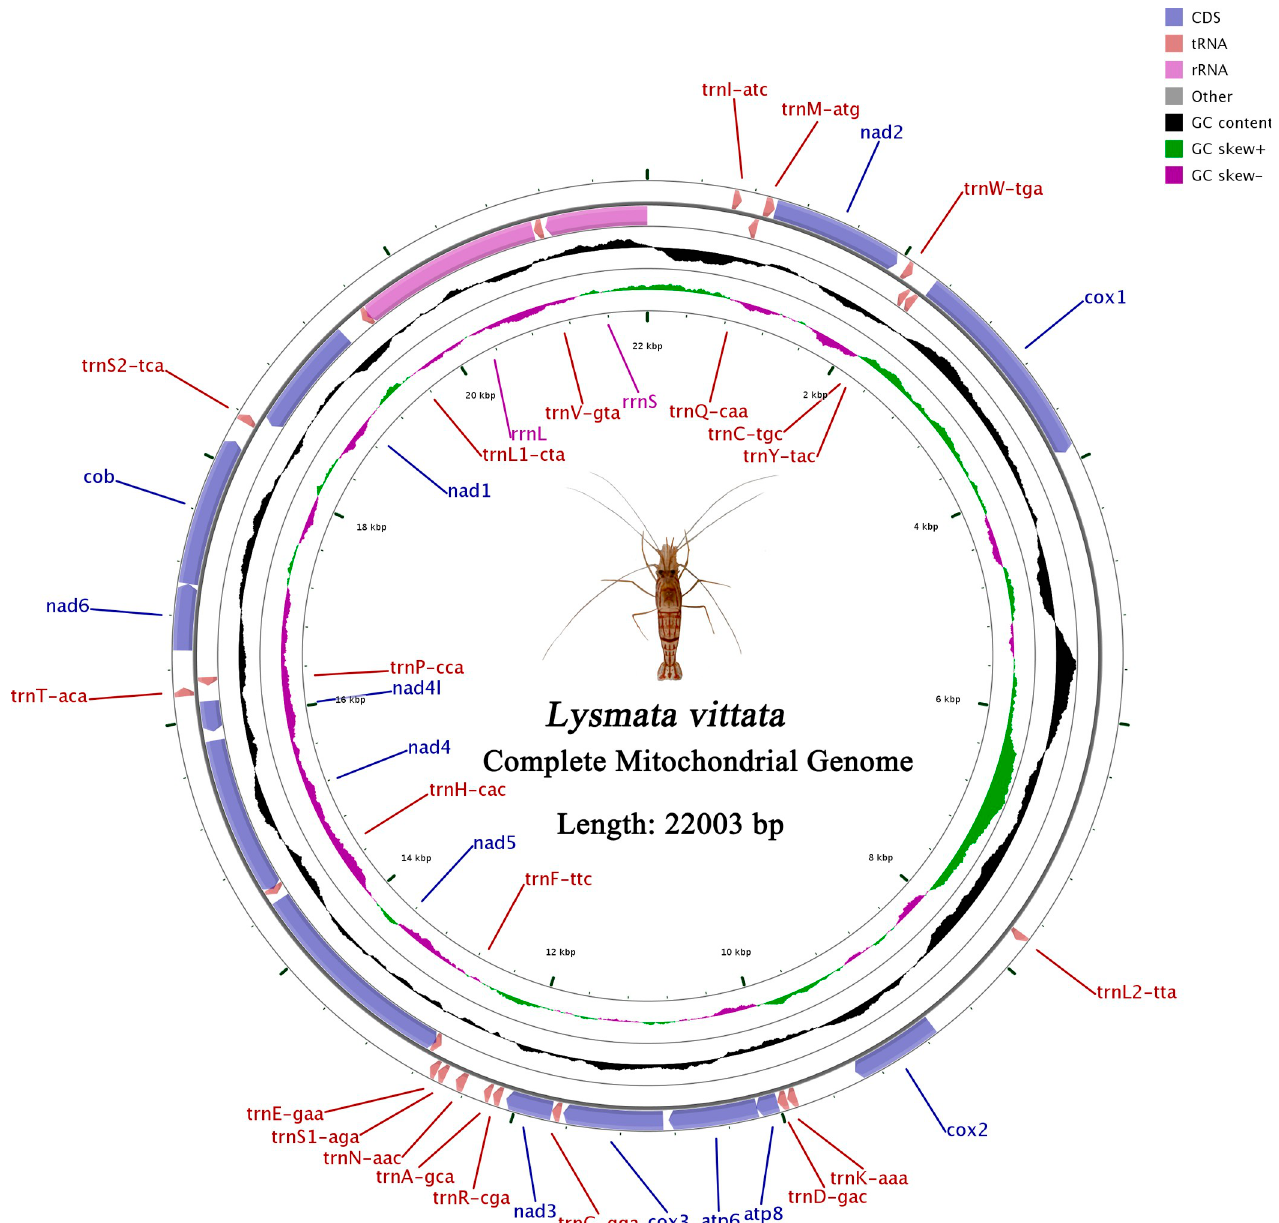
Fig 1. Mitogenome map of Lysmata vittata . The genes outside the map were coded on the F strand, whereas the genes on the inside of the map are coded on the R strand. The middle black circle displays the GC content and the inside purple and green circle displays the GC skew.